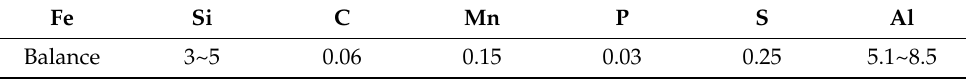
Table 1. Chemical composition of silicon steel sheets expressed as weight percentages.